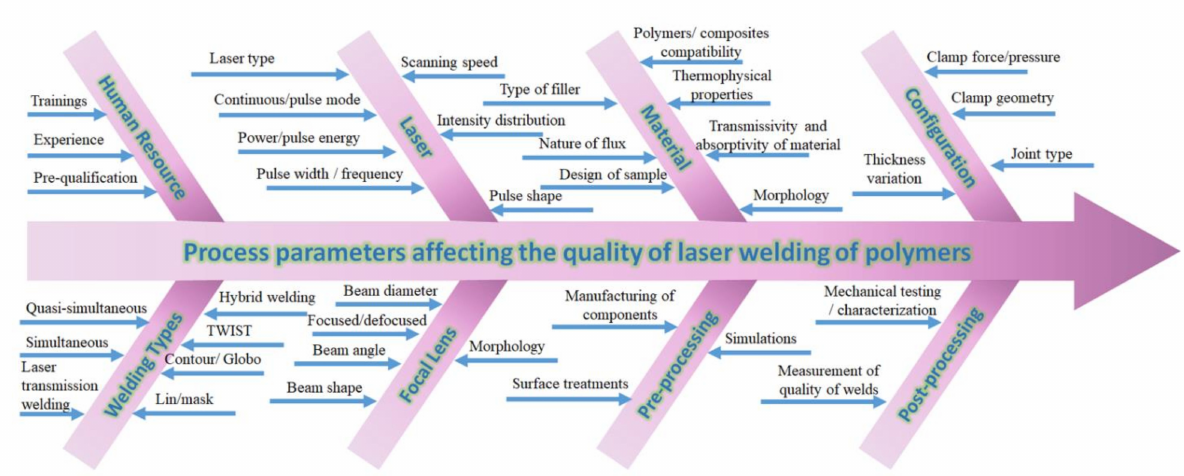
Figure 3. Ishikawa diagram representing the various factors influencing on quality of laser welding of polymers. Authors’ self-created diagram.